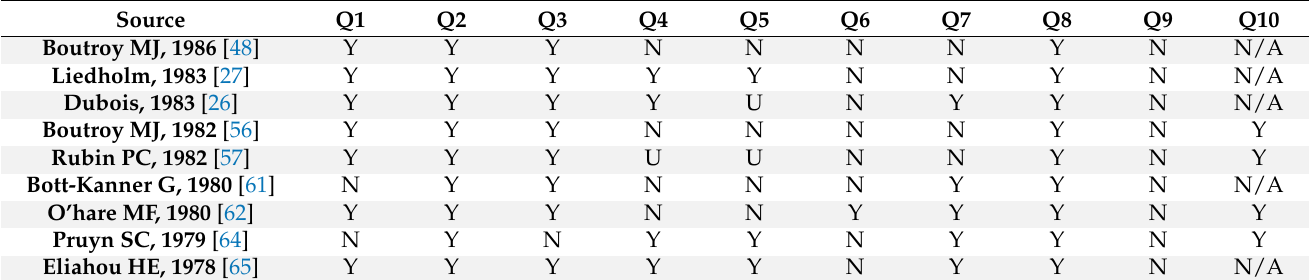
Table 6. Quality of 9 case series.